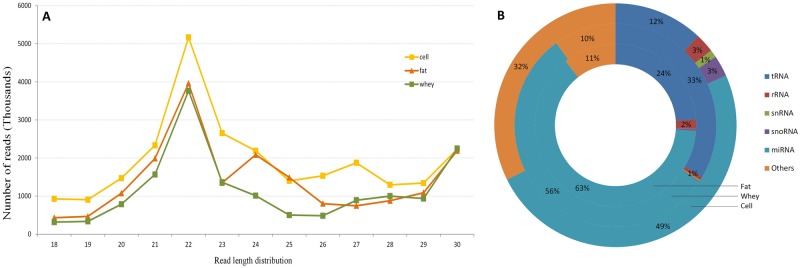
Small RNA length distribution (A) and small RNA species (B).RNA species with a proportion lower than 1% were not labeled in B.